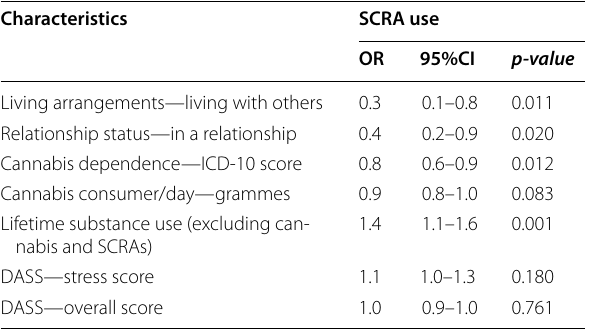
Table 6 Reasons for first, subsequent use and no use of SCRAs 154) with most important reason for each highlighted and =